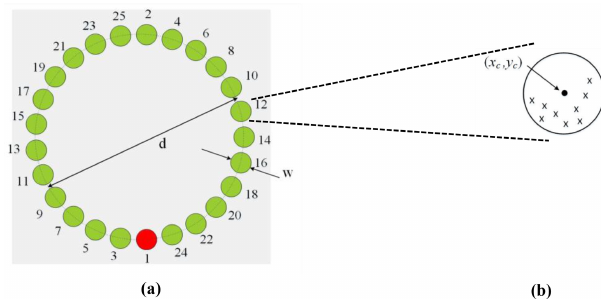
Figure 2. (a) Pattern of the multi-directional tapping task: d = distance of movement; w = target width. (b) Enlargement of one target circle; ( x c , y c ) is the actual clicked target; “x” indicates the clicked-coordinate spreading of each target